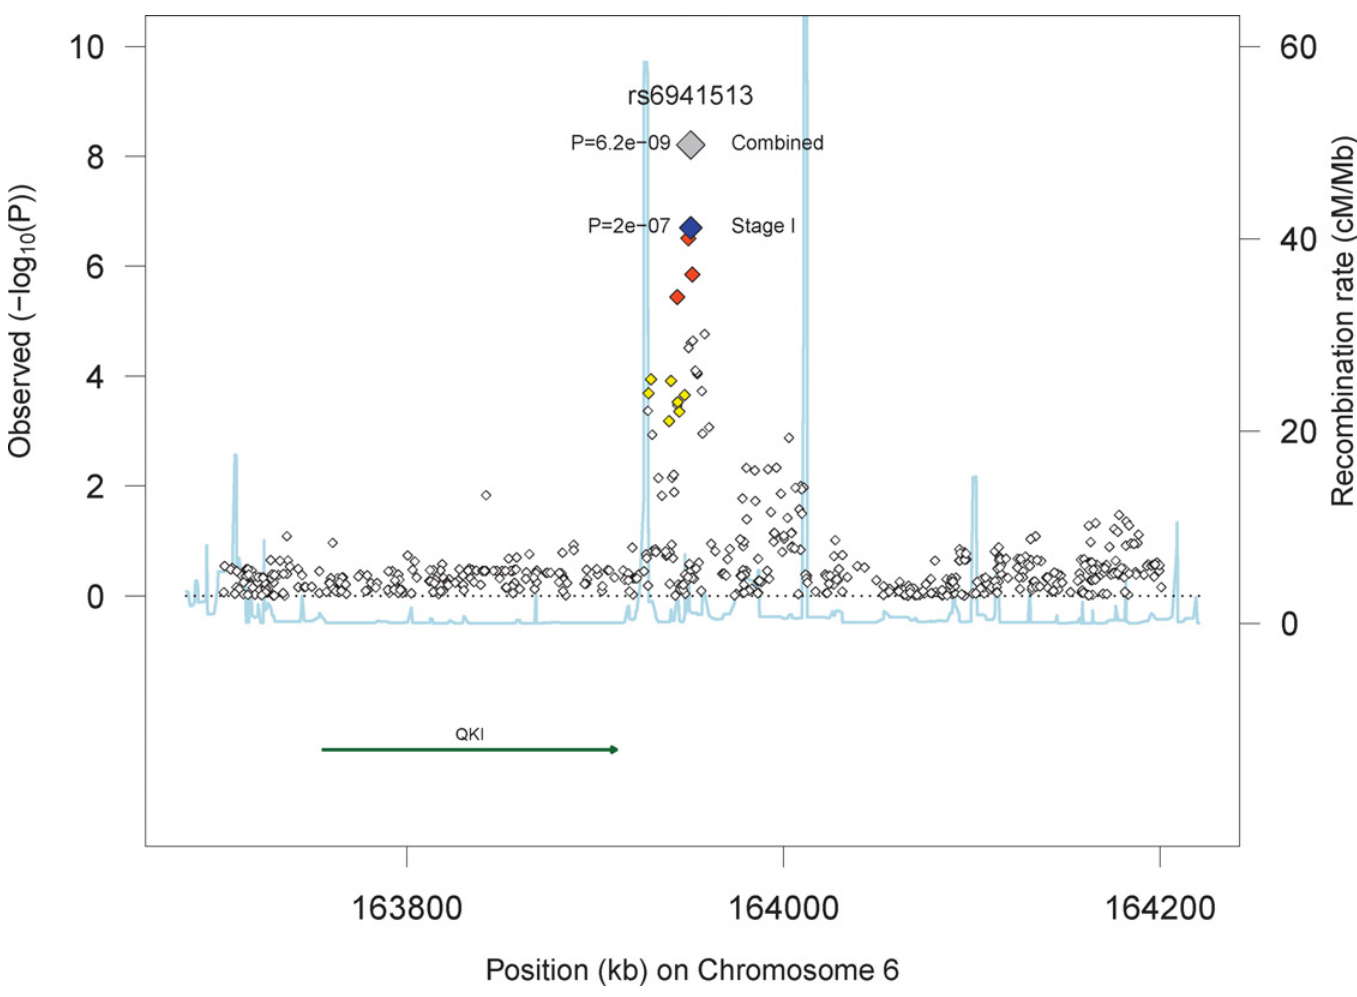
Fig 2. Regional plots for the association of SNPs with MI in the region of QKI